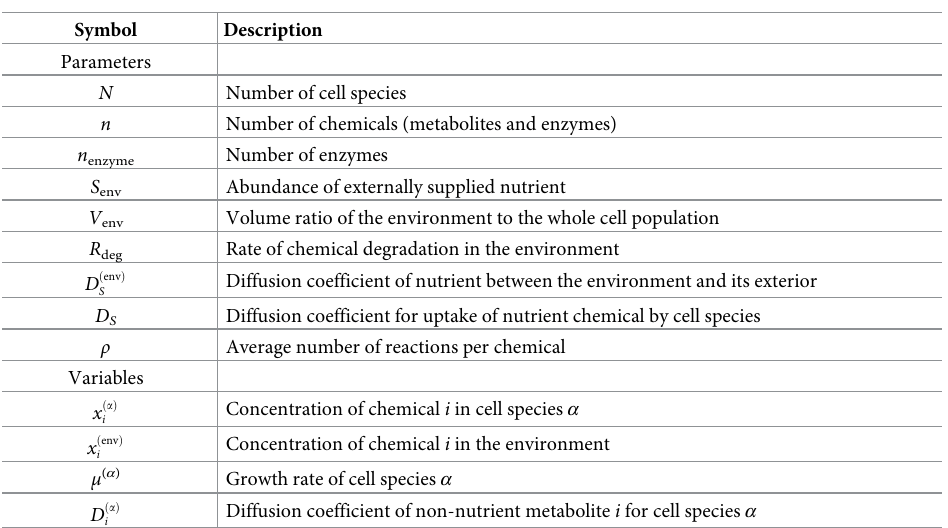
Table 1. Parameters and variables in our